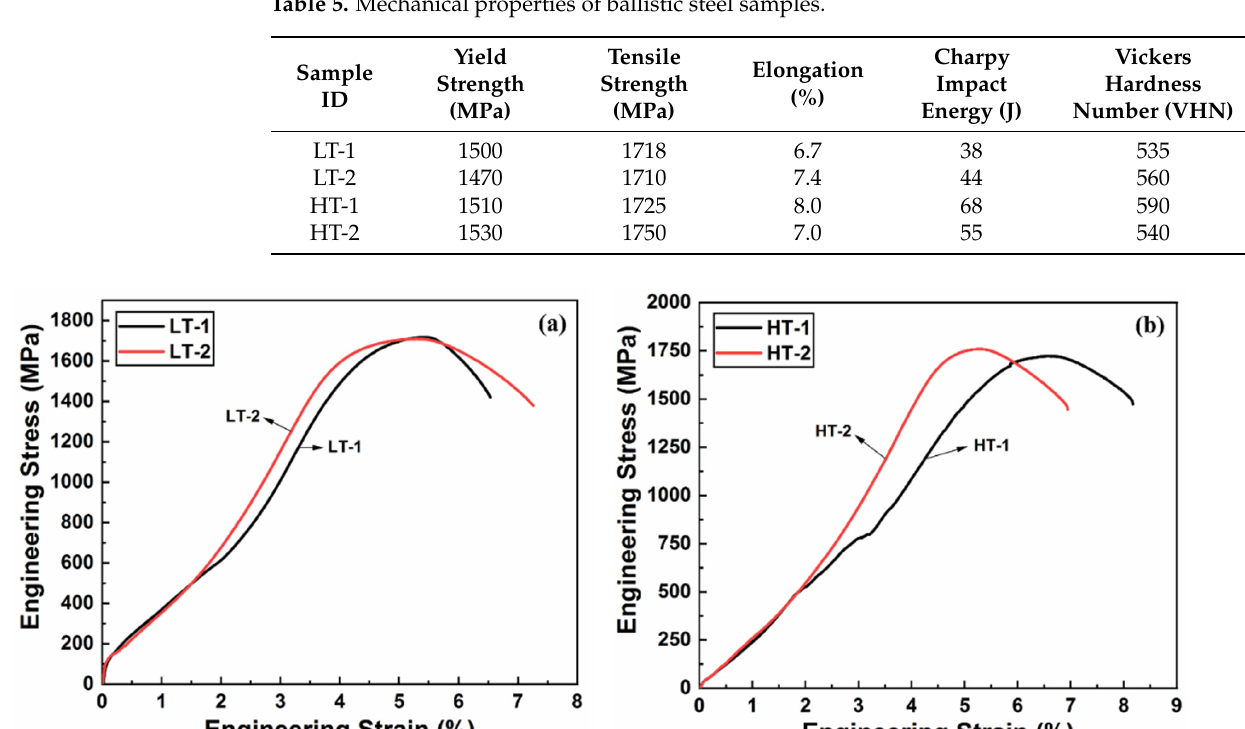
Table 5. Mechanical properties of ballistic steel samples.